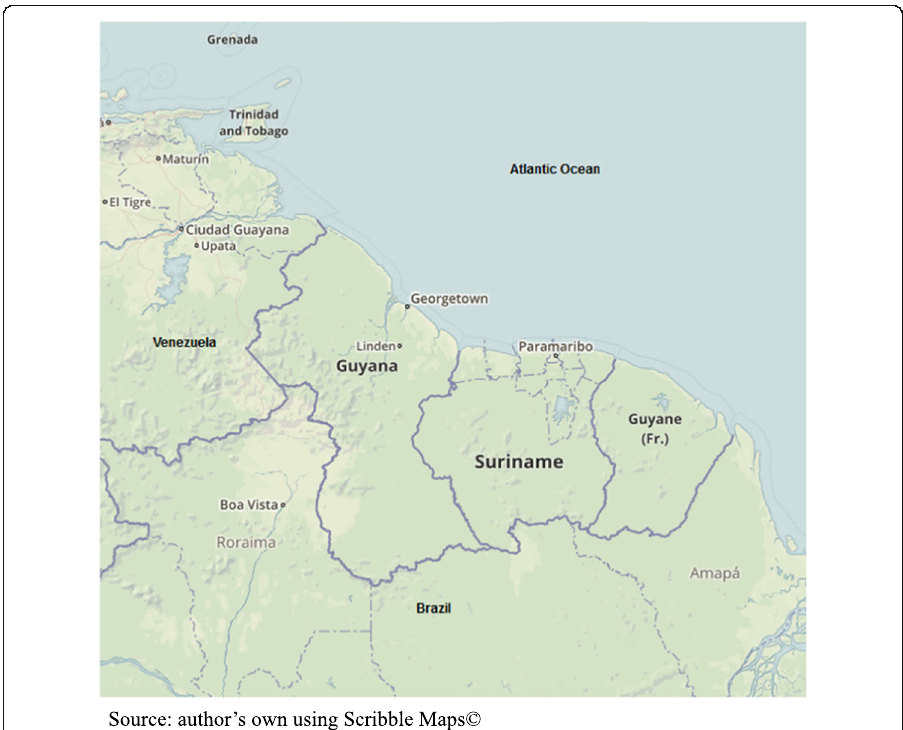
Fig. 1 Map of Guyana, Suriname and French